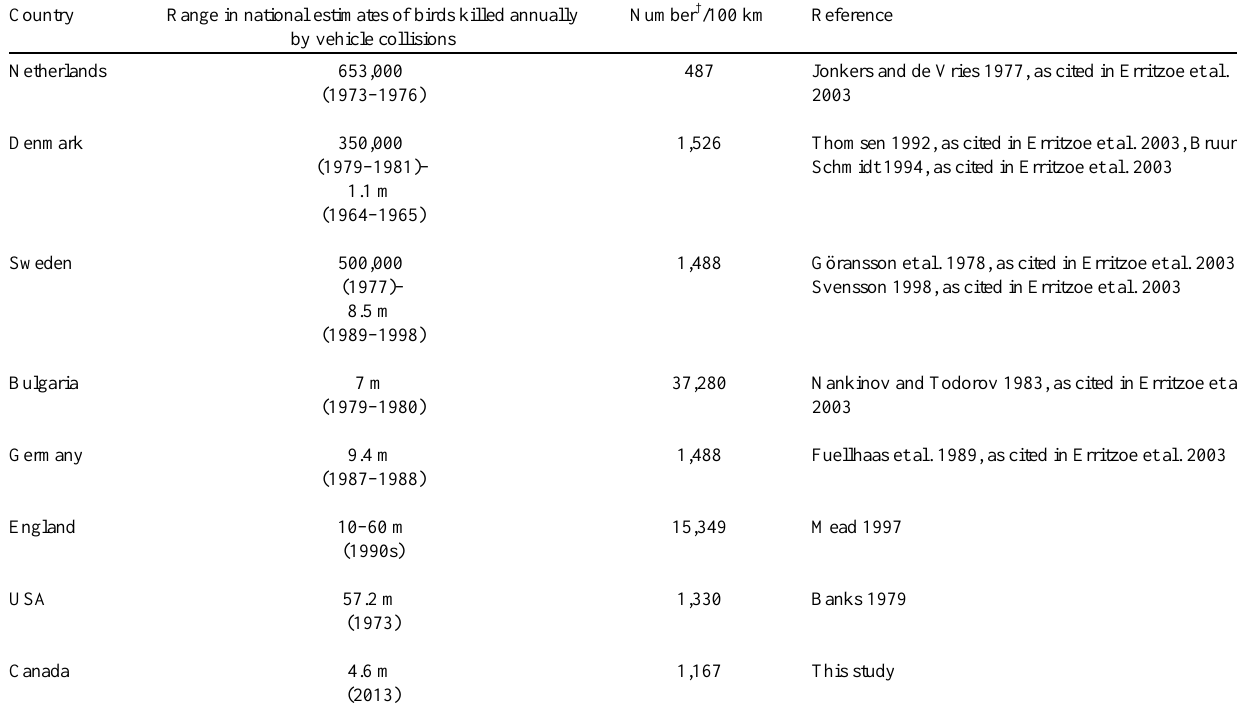
Table 5 . Highest reported national estimates of total number of birds killed annually by vehicle collisions